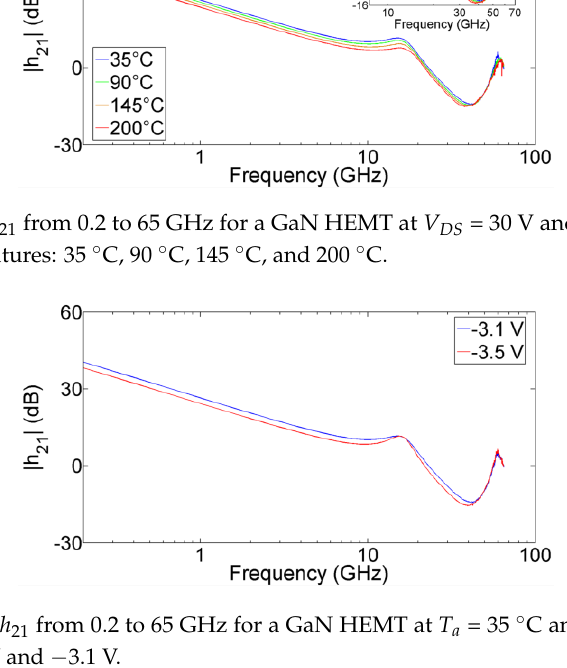
Figure 10. Measured h 21 from 0.2 to 65 GHz for a GaN HEMT at T a = 35 °C and V DS = 30 V for two values of V GS : − 3.5 V and − 3.1 V.